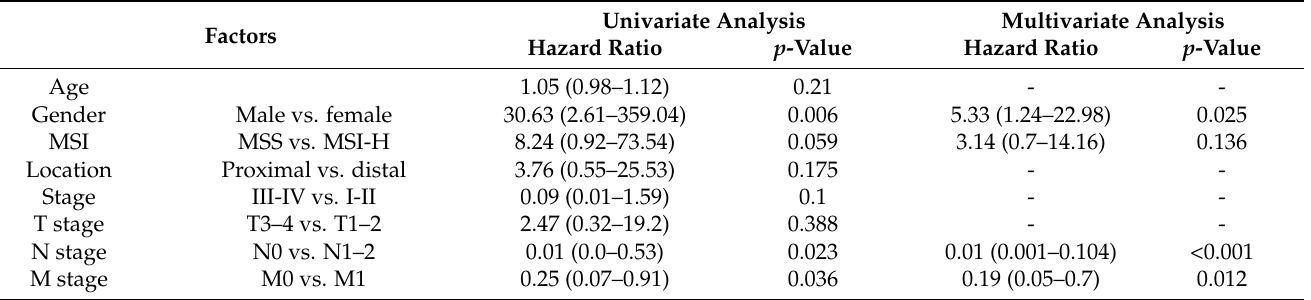
Table 3. Cox proportional hazard regression for clinical